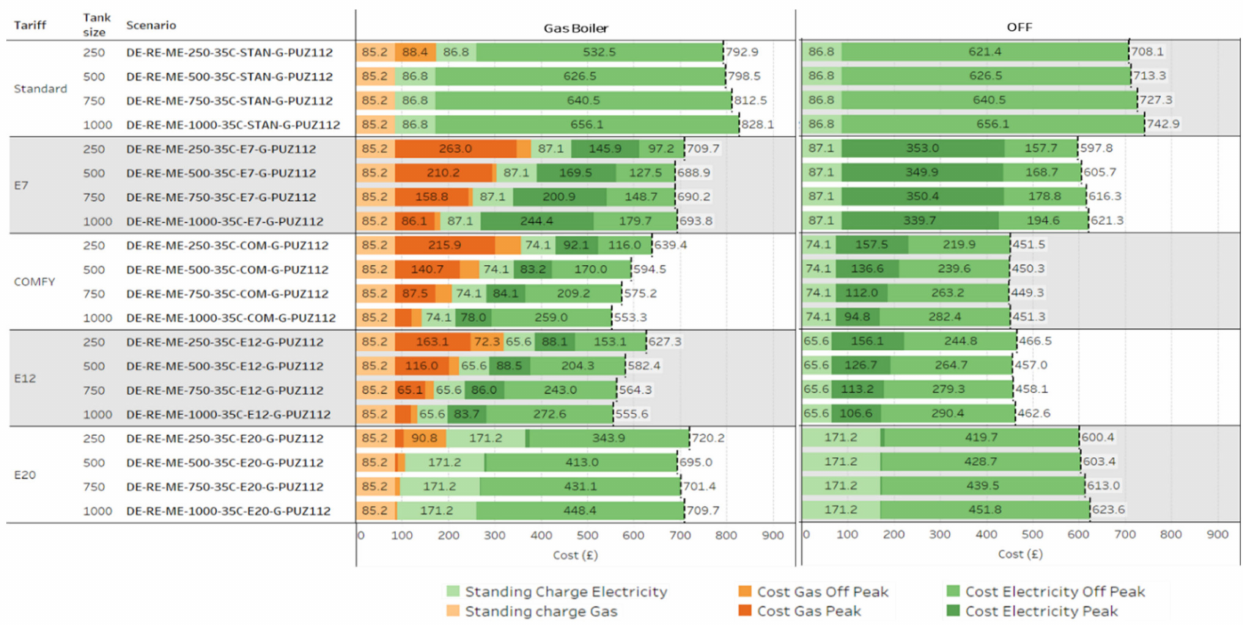
Figure 7. Heating cost of backup scenario analysis for heat pump and backup heater during off-peak and peak